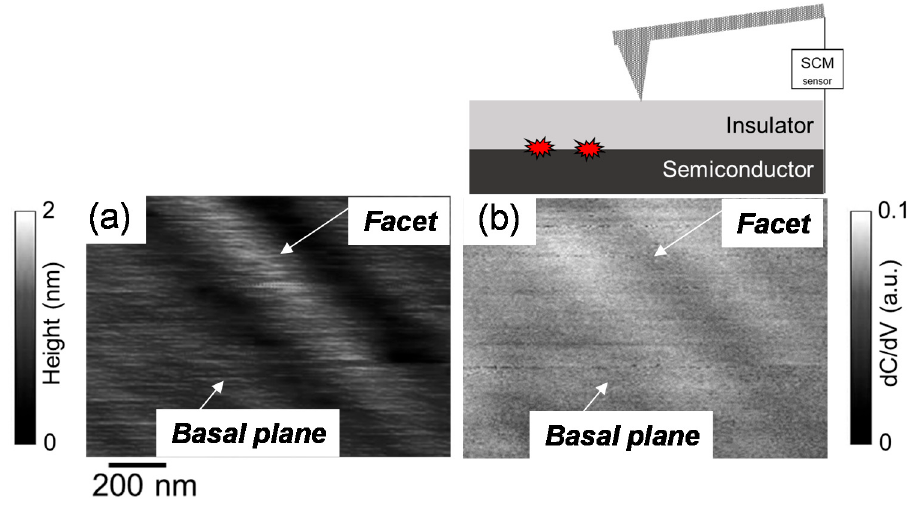
Figure 6. ( a ) Surface morphology acquired with an AFM scan on the bare SiO 2 surface, and ( b ) SCM map indicating a non-uniform spatial distribution of the surface potential.